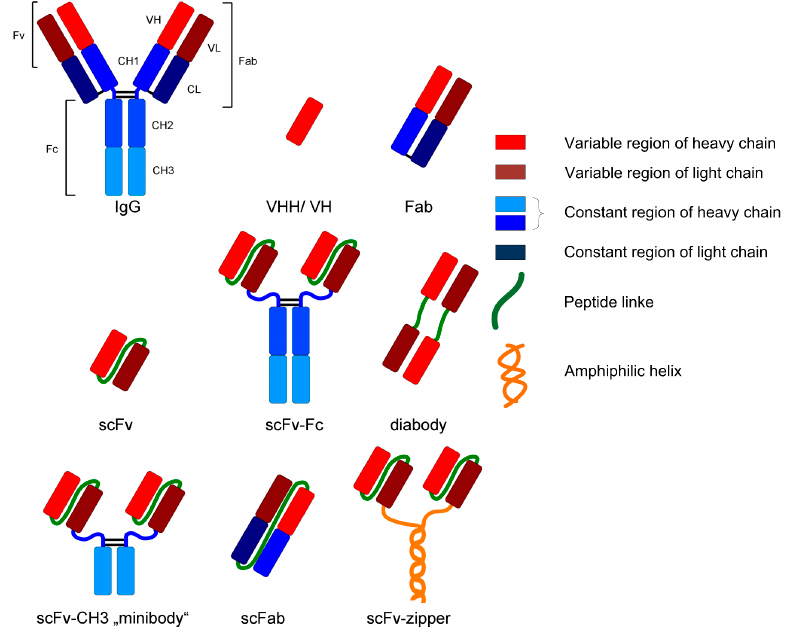
Figure 2. Various formats of recombinant antibodies